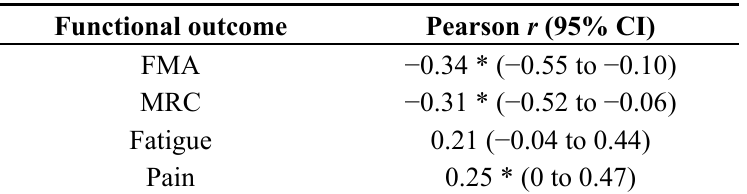
Table 4. Predictive ability of pre-treatment 8-OHdG levels on post-treatment functional outcomes in stroke patients ( N = 61). Abbreviations: 8-OHdG, 8-hydroxy-2'-deoxyguanosine; CI, confidence interval; FMA, Fugl-Meyer Assessment; and MRC, Medical Research Council scale. * p <